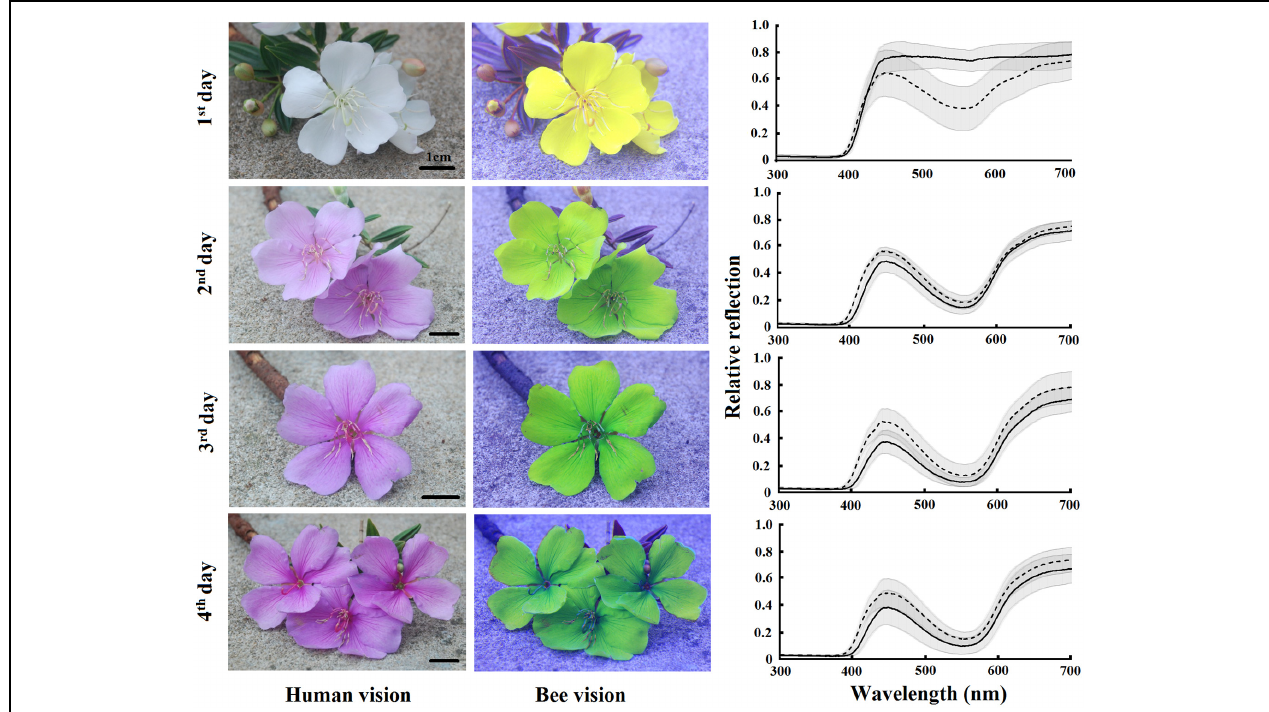
FIGURE 3 | Color patterns of T. pulchra flowers from the first to the fourth days of anthesis. Photos are shown in conventional photography (red, blue, and green channels) and replacing the blue channel by the red channel of the UV photography (as the red sensor is UV-sensitive), the green channel by the blue channel of the normal